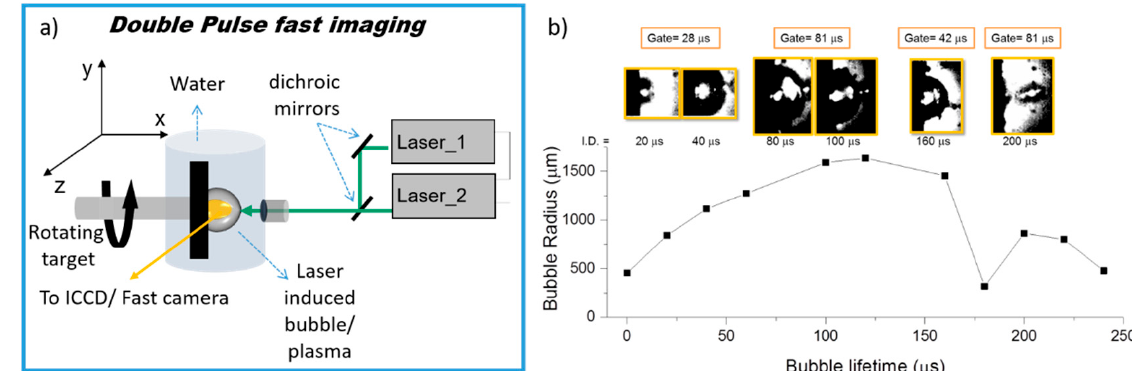
Figure 10. ( a ) Sketch of the experimental set-up for the double pulse fast imaging technique. ( b ) (Reprinted from Ref. [10] with permission from Elsevier) shadowgraph images of bubble and plasma induced by DP-PLAL on an Ag target in water at different interpulse delays (and with different camera gate width). The images of ( b ) show the plasma induced by the second laser pulse inside the bubble induced by the first laser pulse, at different moments during the bubble lifetime. The temporal evolution of the laser-induced bubble radius as measured from shadowgraph images during a single-pulse LAL experiment is reported by comparison. (Laser wavelength = 532 nm, irradiance = 17.5 GW cm − 2 , ICCD gate width is reported on each frame).